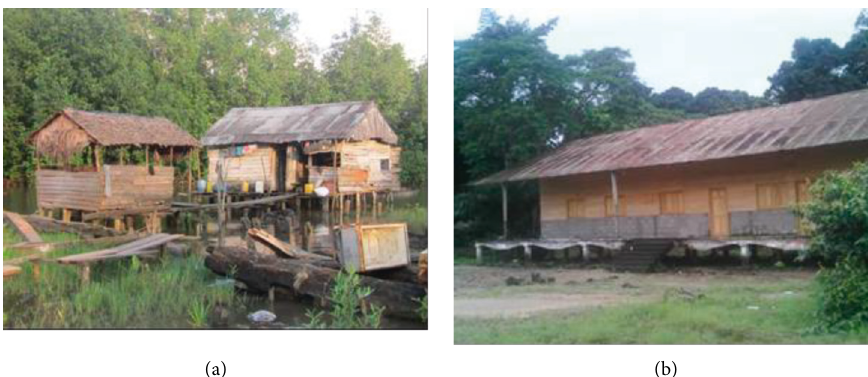
Figure 12: Houses elevated to adapt to flooding in Ngalamberi settlement 5 (a) and at the Manoka council headquarters